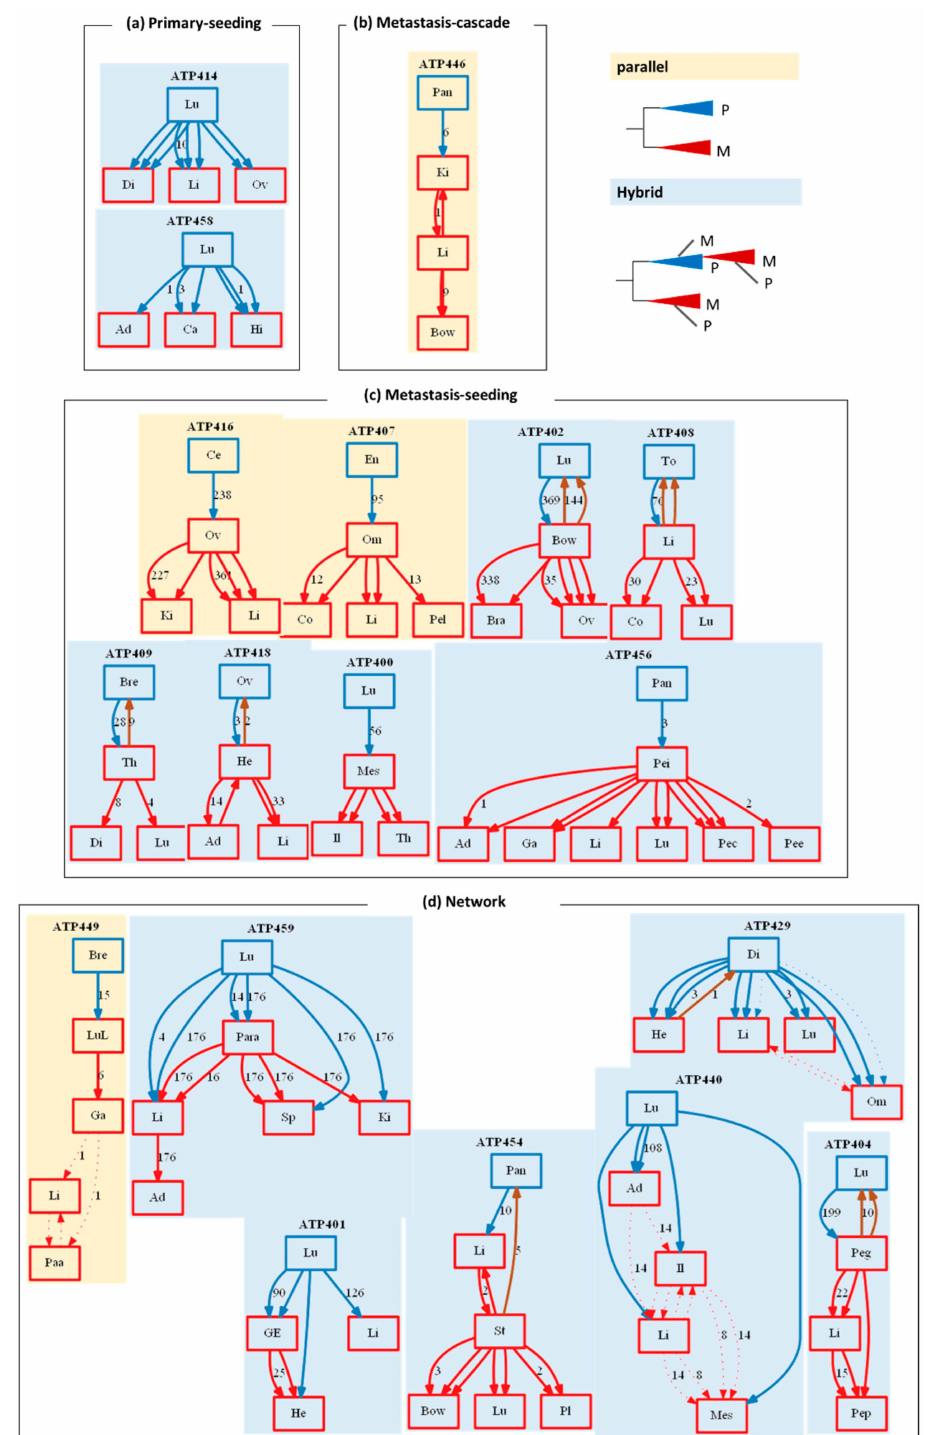
Figure 5. Metastatic migration histories inferred from clone phylogenies in Figure 4. The migration maps for each patient ID (top) were classified into seeding models based on their shapes ( a – d ). The number of variants mapped is shown next to a path (solid: high support, dashed: low support, blue: P → M, red: M → M, brown: M → P) between sites (Primary: blue and metastatic: red) when their count is greater than zero. An abbreviation (Figure 4 legend) for each tumor site labels each